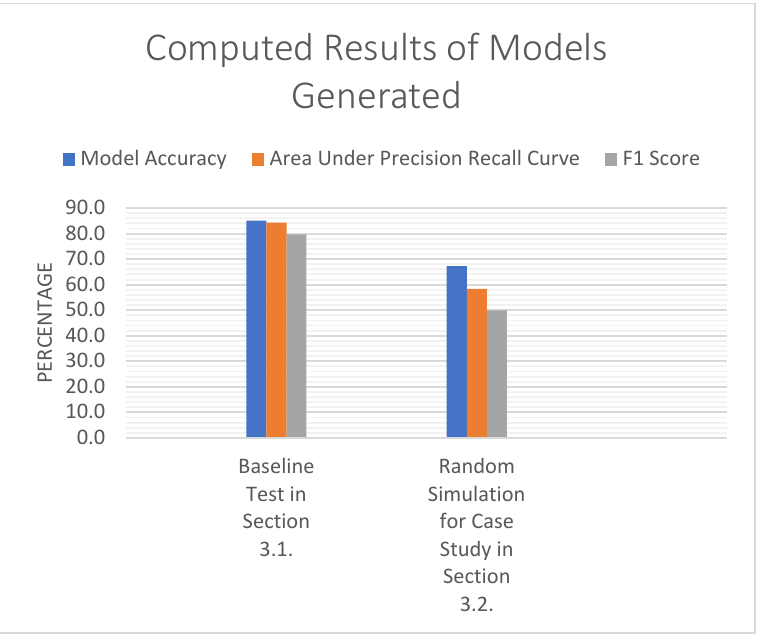
Figure 5. Results from training models in examples.